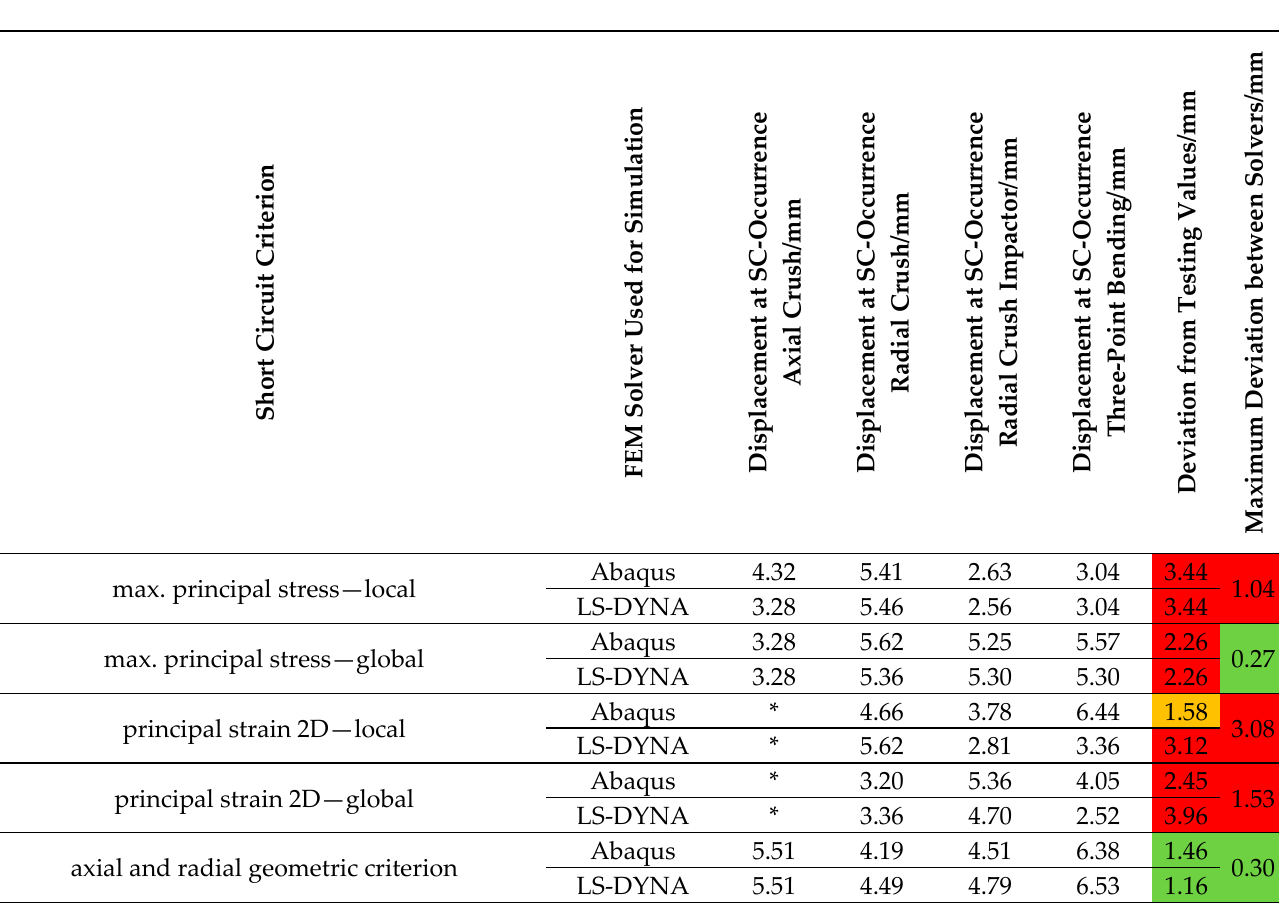
Table 4. Results for virtual short ‐ circuit detection for four mechanical load cases using different